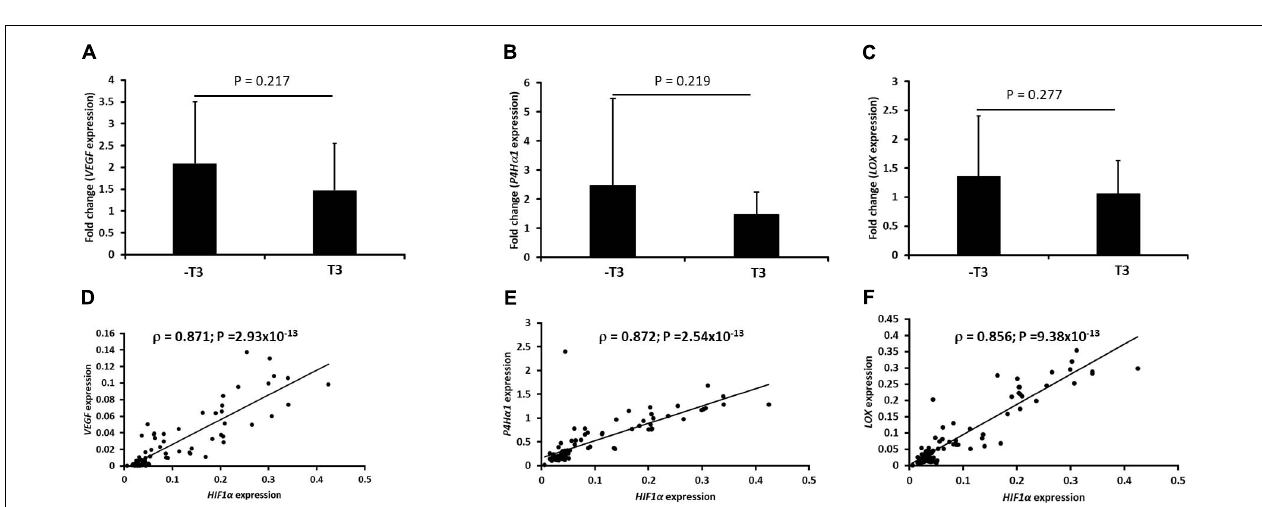
FIGURE 3 | Induction of a biased panel of hypoxia-inducible genes and Spearman correlation plots with hypoxia-inducible factor-1 α ( HIF1 α ) expression in IFP-MSC pellets. Fold change of mRNA expression of VEGF , P4H α 1 , and LOX for seven donors with independent duplicates ( N = 7, n = 14 per experimental group) under hypoxia (2% O 2 ) after normalization to the same gene expression under normoxia (21% O 2 ): (A) vascular endothelial growth factor ( VEGF ), (B) prolyl-4-hydroxylase- α 1 ( P4H α 1 ), and (C) lysyl oxidase ( LOX ). Spearman correlation of HIF1 α mRNA with (D) VEGF , (E) P4H α 1 , and (F) LOX . The geometric mean of three housekeeping genes was used for initial normalization: tyrosine 3-monooxygenase/tryptophan 5-monooxygenase activation protein, zeta polypeptide ( YWHAZ ), β -actin ( β -actin ), and β -2-microglobulin ( B2M ) were used. Bar data are mean ± standard deviation. Statistical comparisons were based on unpaired Student’s t -test between no TGF β 3 (i.e., –T3) and with TGF β 3 (i.e., +T3) groups.